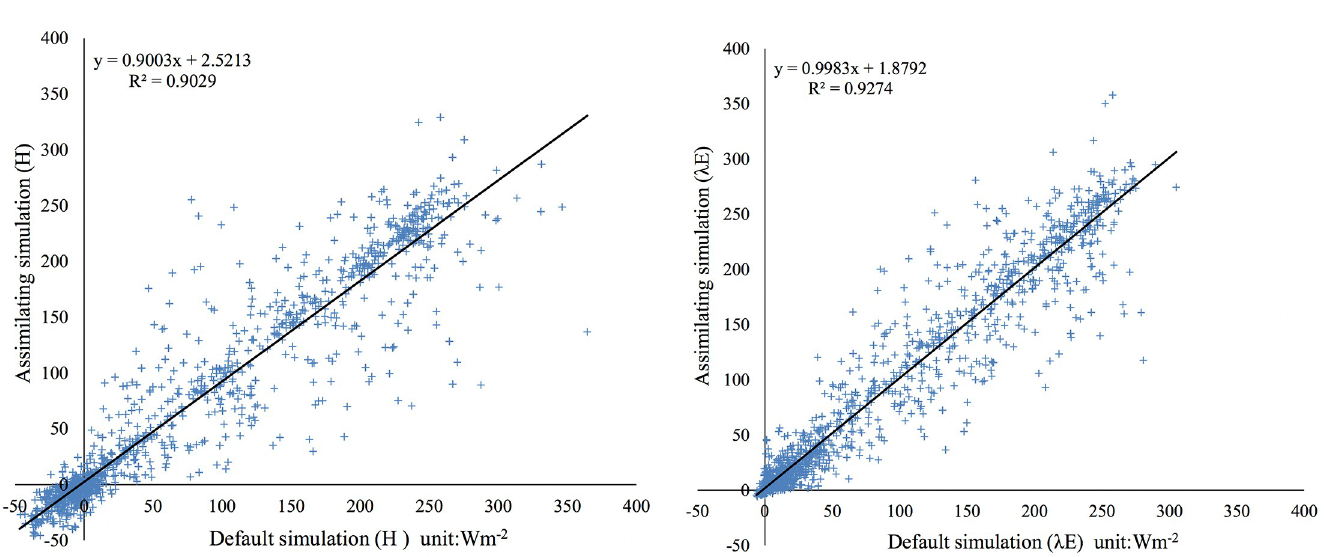
Fig 3. Scatter diagrams of the sensible heat flux H and latent heat flux λ E estimated using the default and assimilation WRF model simulations (the 1:1 line is shown as a black line).